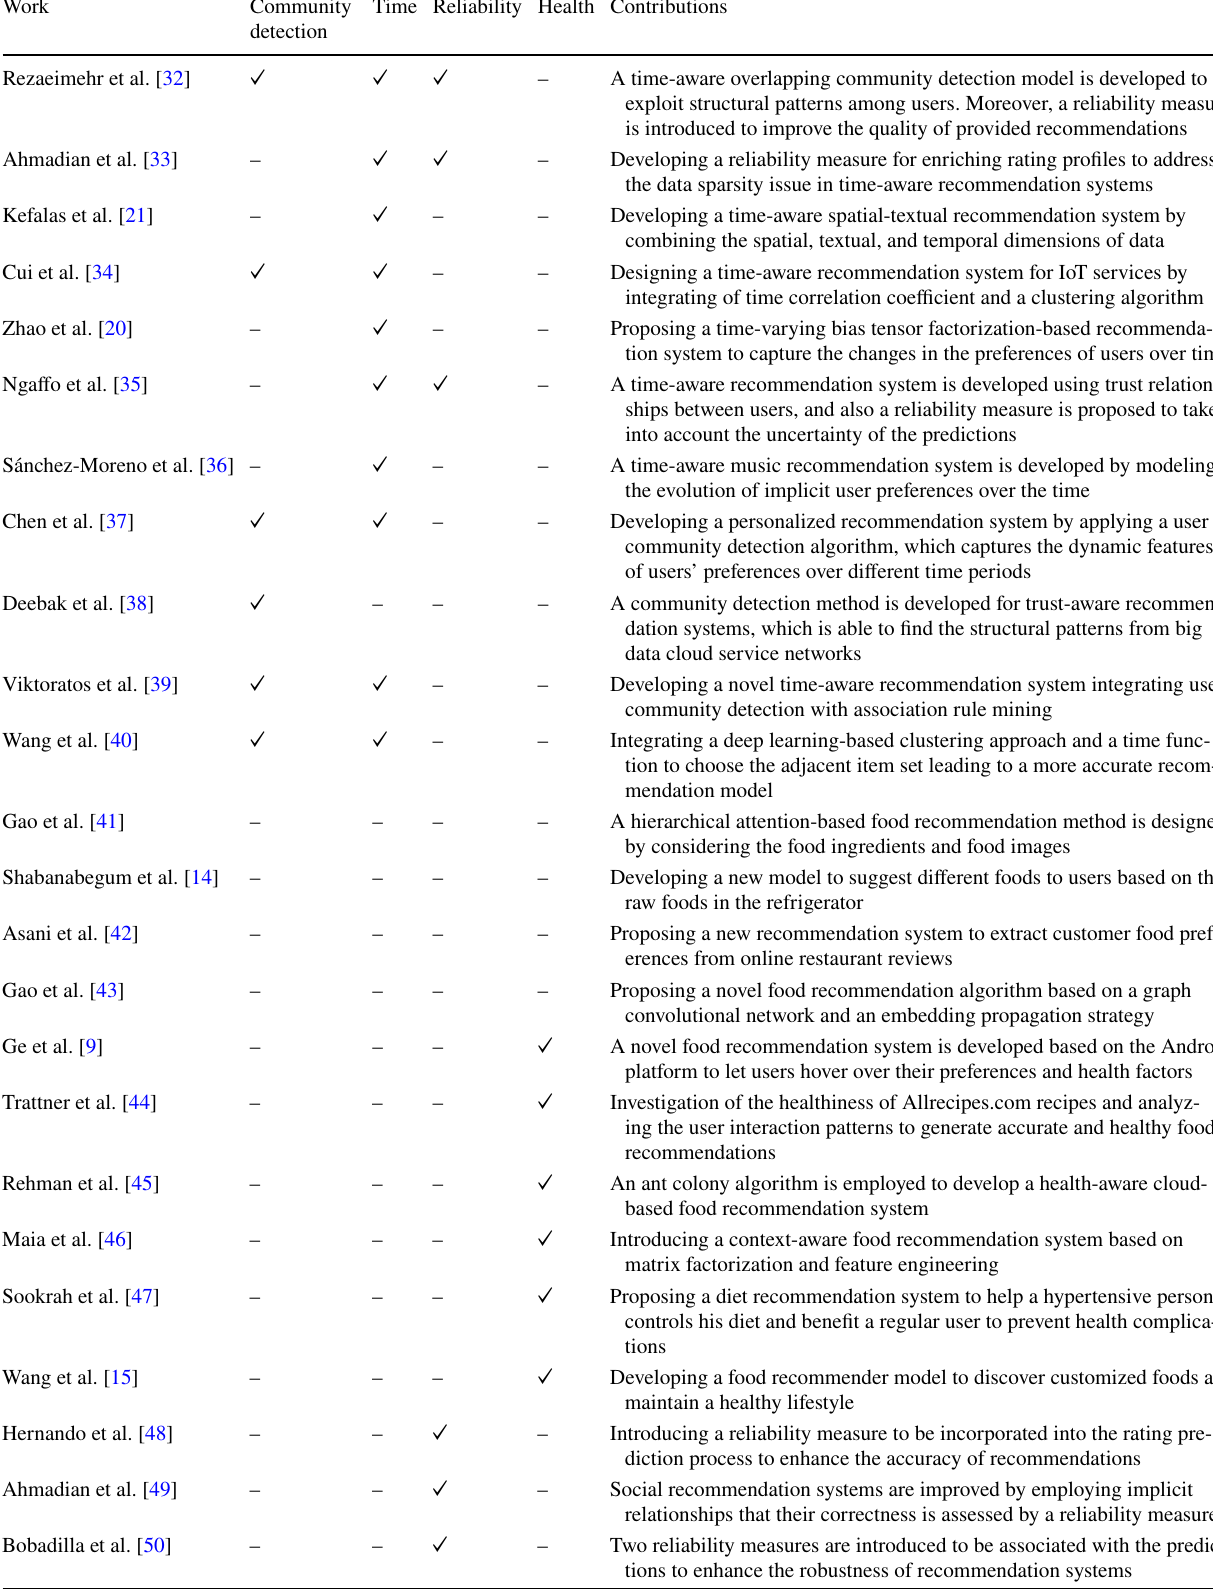
Table 1 The summarized descriptions of the related works in terms of different aspects compared to the proposed method